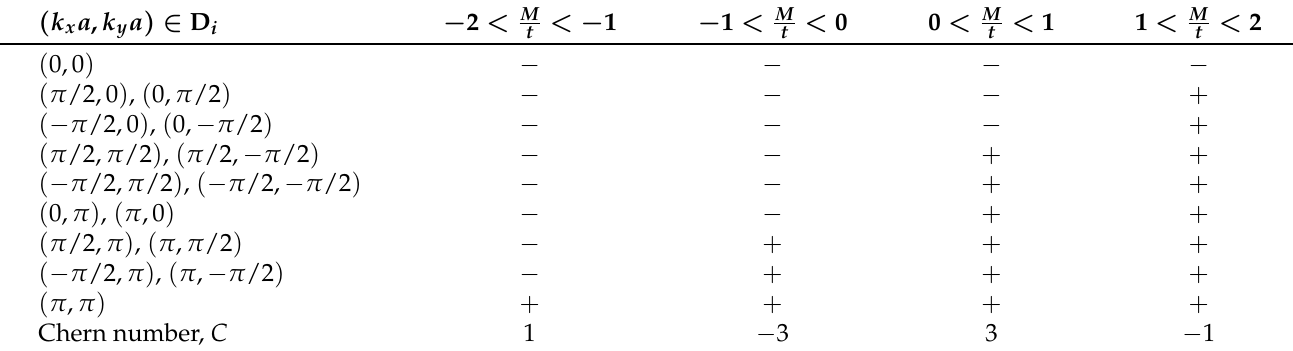
t cos k x t cos k y at different Dirac points D i for various Chern insulator phases, along with − − ∑ ( ∂ k d d ) z Sgn ( d z ) ∂ k k D i Sgn 2 x y × ∈